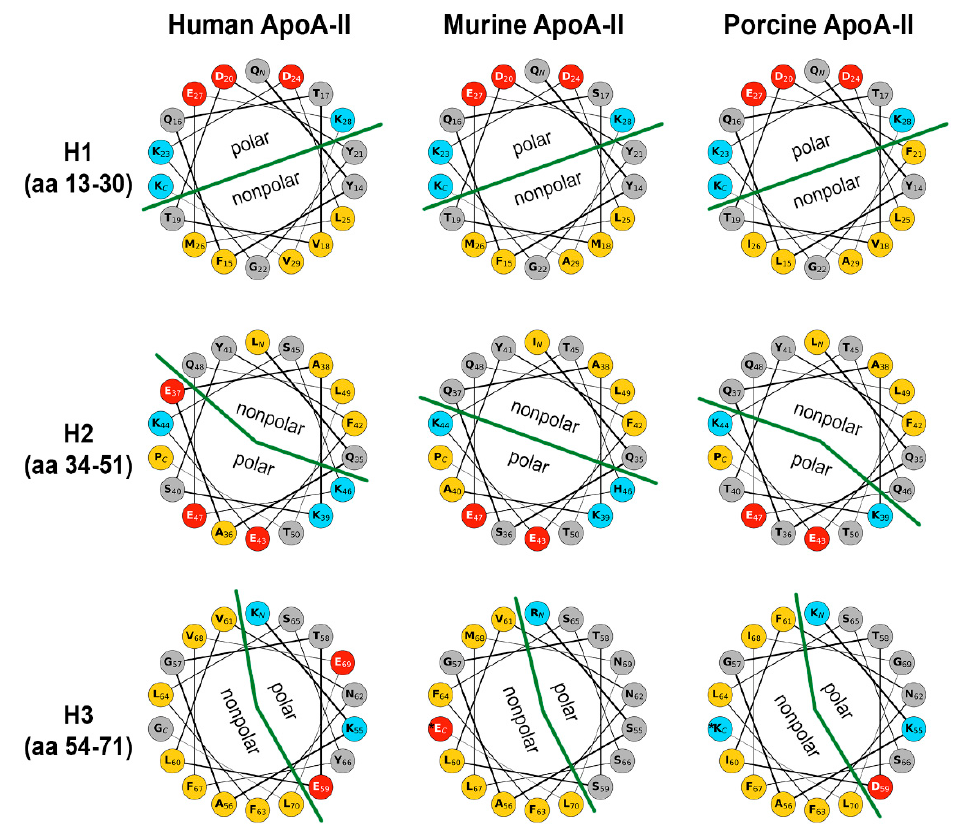
Figure 4. Comparison between the secondary structures of apolipoprotein A-II from human, murine, and porcine origin. The HelicalWheel tool of the Galaxy CPT public platform (https://cpt.tamu.edu/galaxy-pub, accessed on the 20 June 2022) was used to generate the plots. Amino acid (aa) color code: yellow-hydrophobic; grey-polar, uncharged; red-negatively charged; blue-positively charged. The green line demarcates the polar from the non-polar regions in the helical wheels. Note the presence of a charged E residue in the murine nonpolar part of H3, and a K residue in the porcine nonpolar part of the H3 region of apoA-II (marked with *) is introducing a disruption in the non-polar region, as compared with the human homolog. However, since this residue is at the C-terminus of H3, it should not significantly alter the nonpolar character of the face. The sequences used for plots are NP_001634.1 for human apoA-II, NP_001292478.1 for murine, and NP_001173223.1 for porcine apoA-II.